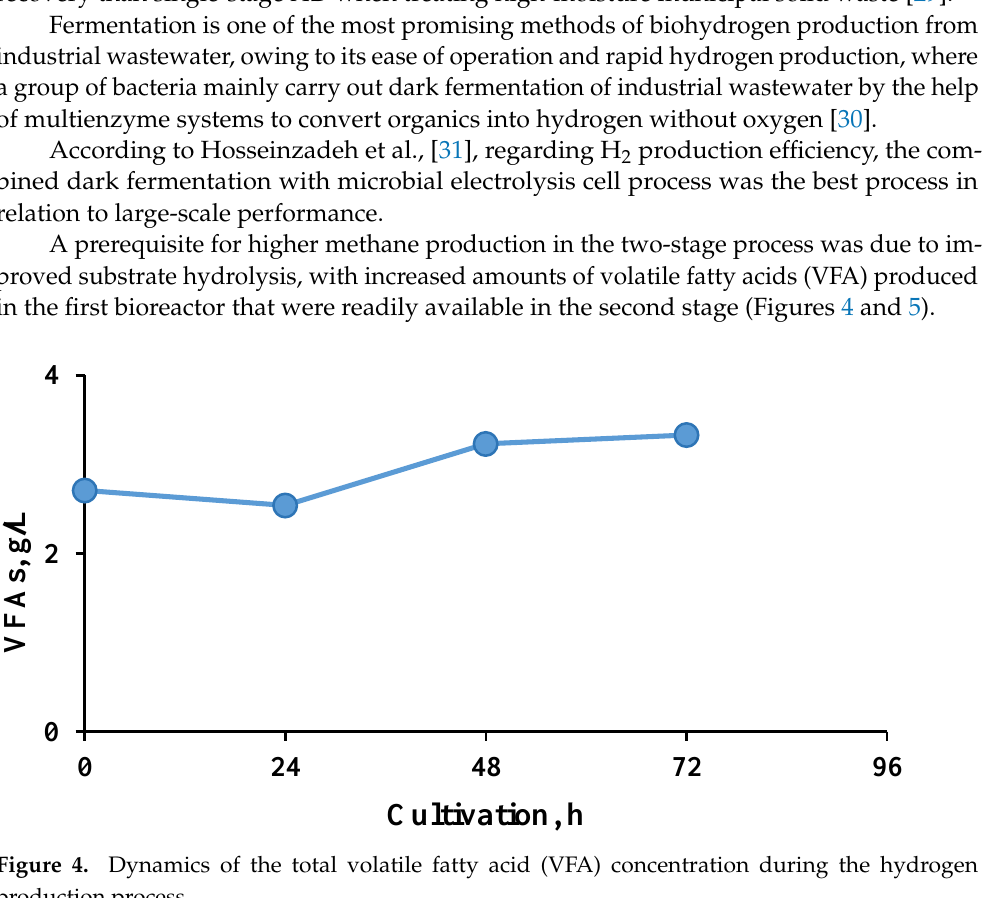
Figure 4. Dynamics of the total volatile fatty acid (VFA) concentration during the hydrogen production process.